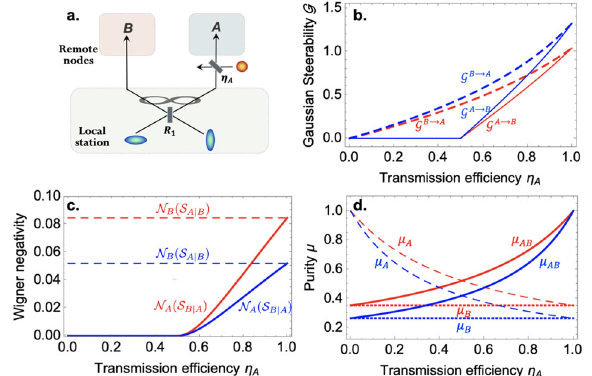
Fig. 3 Remotely generated Wigner negativity and initial Gaussian steering and purity in an asymmetric scenario. a Scheme of a two- mode squeezed vacuum state with one lossy channel on mode A , where R 1 is a balanced beam splitter. b The initial asymmetric Gaussian steerability with different squeezing levels r = 1 (blue) and r = 0.85 (red), corresponding to a quadrature noise reduction of − 8.7 dB and − 7.4 dB, respectively. Loss has a more signi fi cant effect on the steering mode A . c After the single-photon subtraction on the steered mode, the amount of induced Wigner negativity on the steering mode corresponding to Gaussian steerability given in b . d The local and global purities of the initial Gaussian states with different squeezing levels.